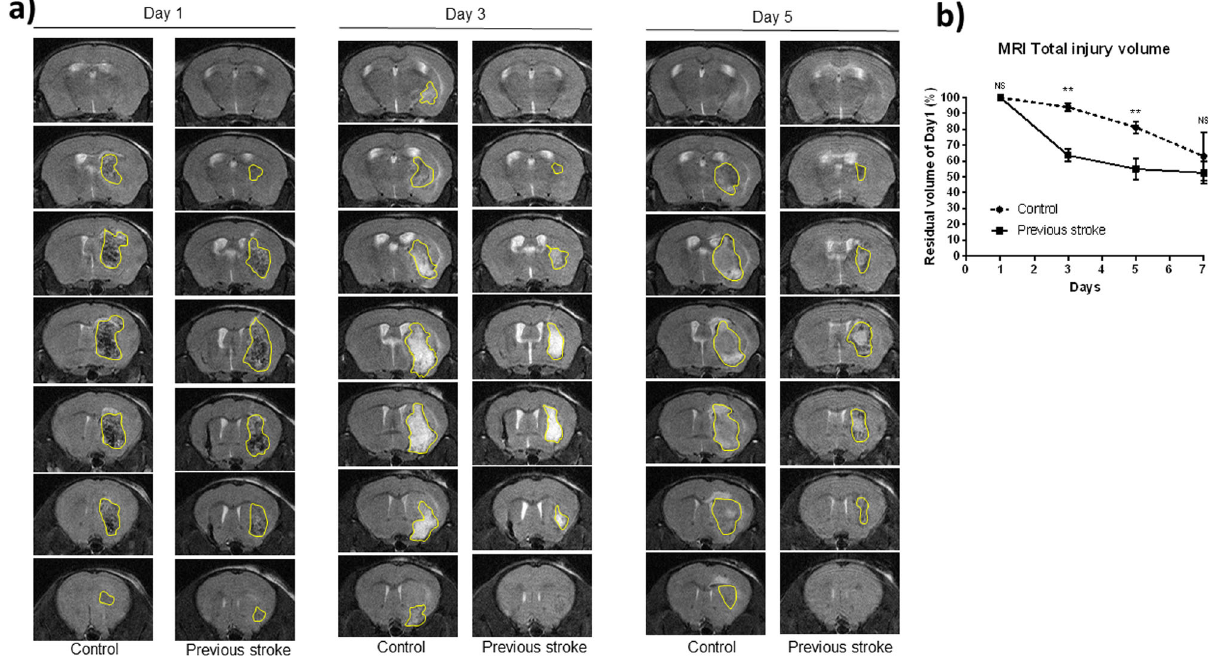
Fig. 3 MRI images obtained on days 1, 3, and 5 after major hemorrhagic stroke induction. a Coronal images, with maximal lesion area outlined in yellow, presented in chronological sequence. b Total lesion volume presented as a percentage of initial lesion volume on day 1 ( n = 5 for each day). Error bars indicate SD. * p < 0.05, ** p < 0.01, NS not signi fi